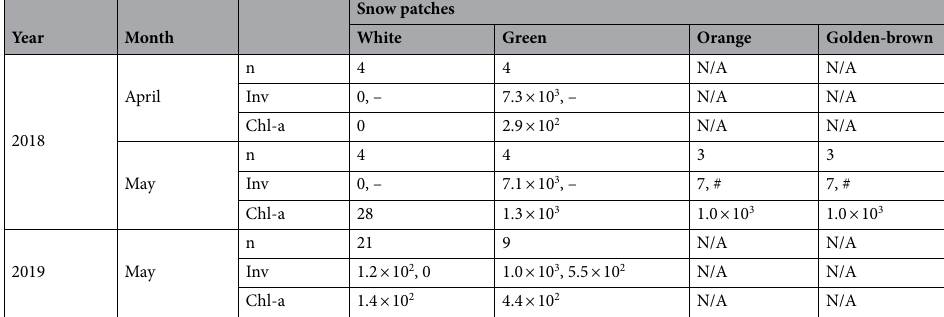
− 1 ), Chl-a: concentration of